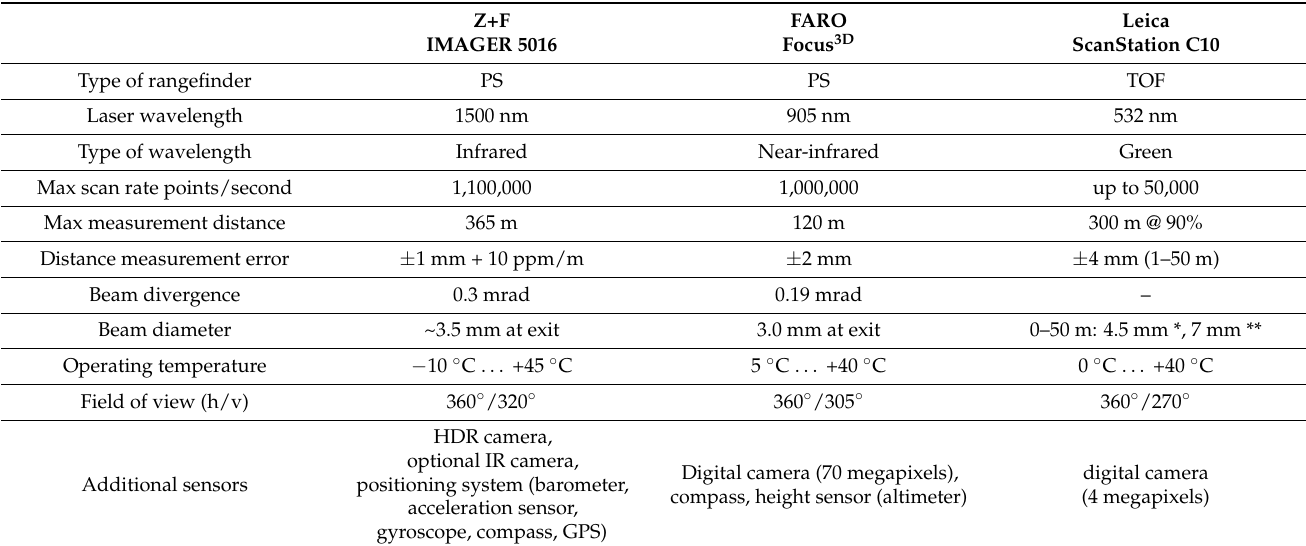
Figure 1. LSSs: prepared targets ( a ), piles of raw materials ( b ), and microscopic views ( c ). Table 2. Basic characteristics of terrestrial laser